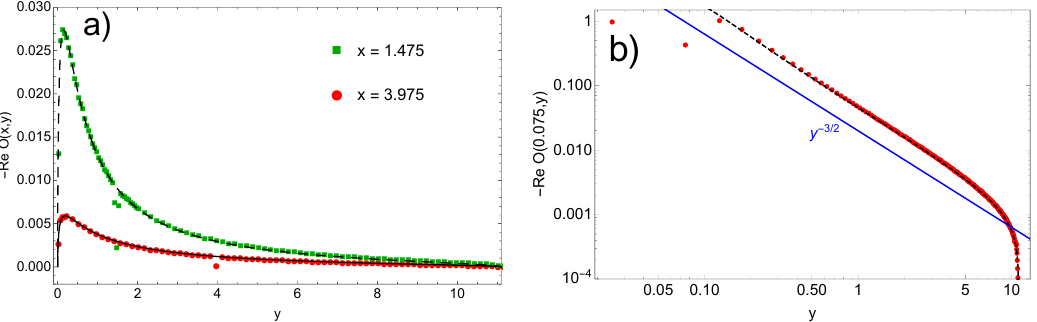
Figure 10 . Cross sections of the two point eigenvector correlation function O 2 ( x; y ) for a) x = 1 : 475 (squares and dashed line), x = 3 : 975 (circles and solid line) and b) x = 0 : 075. The numerical data (points) are obtained by diagonalization of 5 10 4 matrices of size N = 100. Black lines are the (cid:1) solutions of (4.15) inserted into (3.7). Interestingly, if one of the arguments is close to the exceptional point x = 0, the large part of the function can be approximated by a